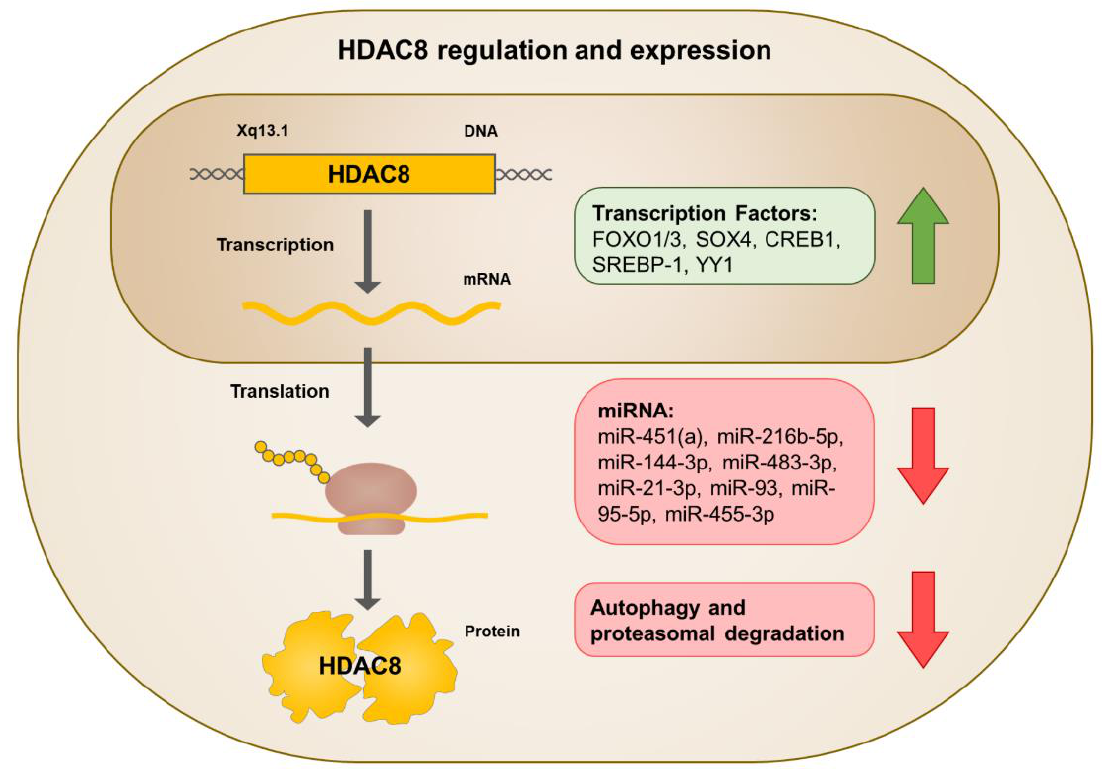
Figure 2. Schematic representation of human HDAC8 and its regulation. HDAC8 is upregulated by transcription factors and downregulated by miRNA, autophagy, and proteasomal degradation.